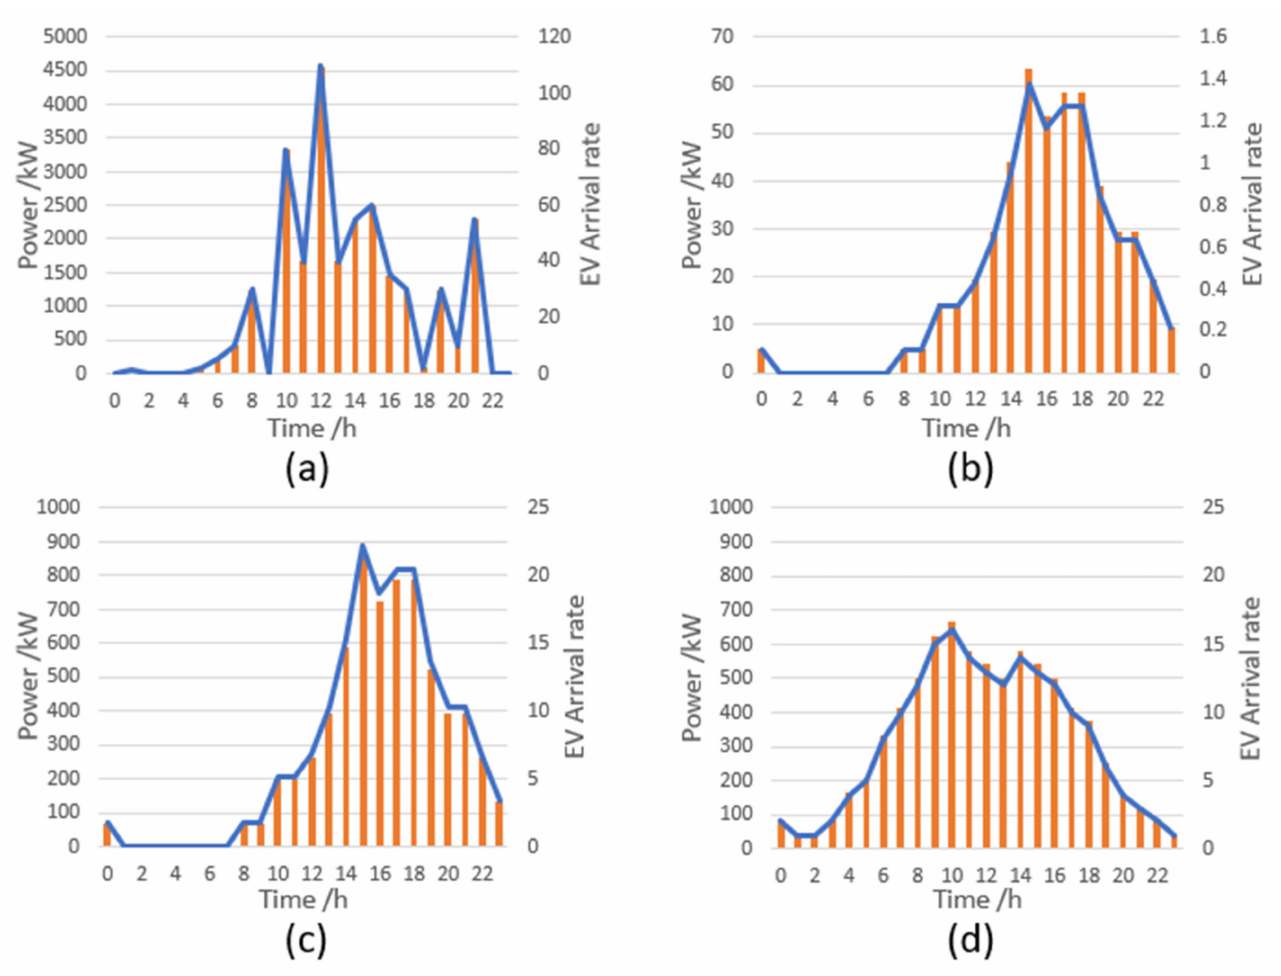
Figure 4. The charging profiles that were used in the simulation. ( a ) Petrol station (PS) charging profile. ( b ) Road usage (RU) charging profile. ( c ) Fast charge (FC) charging profile. ( d ) Drive-4-Data (D4D) charging